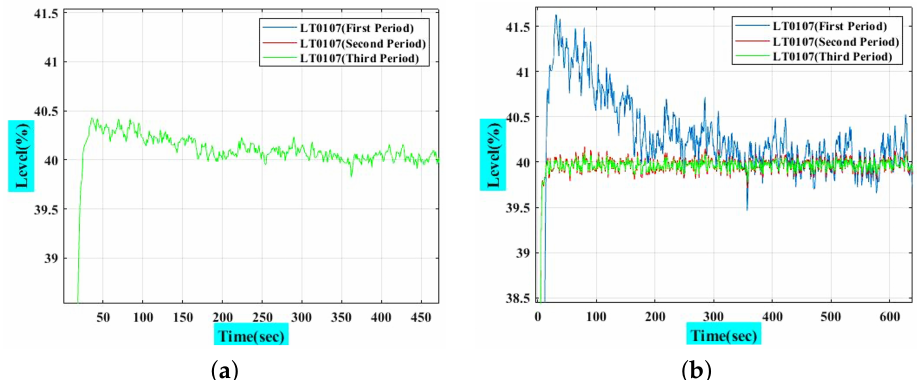
Figure 16. System response under process noise for two approaches (online and offline tuning): ( a ) offline tuning with process noise; ( b ) online tuning with process